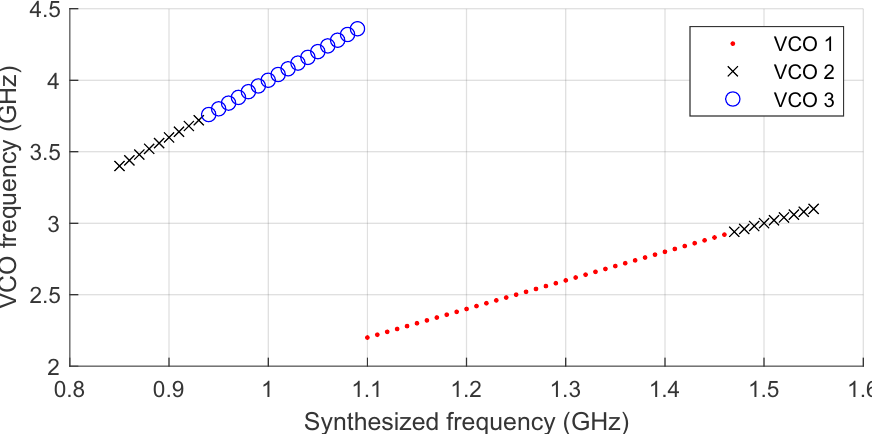
Figure 10. Correspondence between the synthesized frequencies on the transmitter and the three dividers used to generate them, denominated here as VCO 1, VCO 2 and VCO